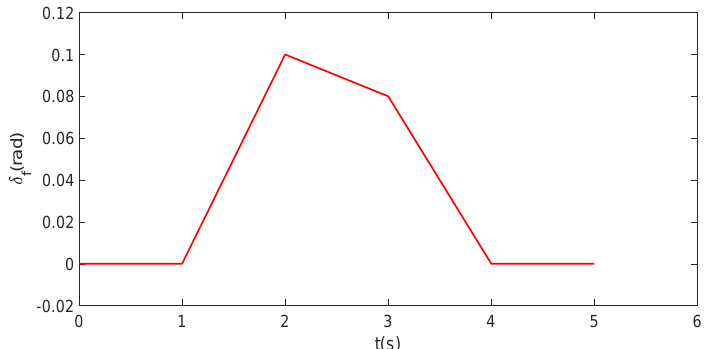
Figure 12. Front wheel input for J-turn